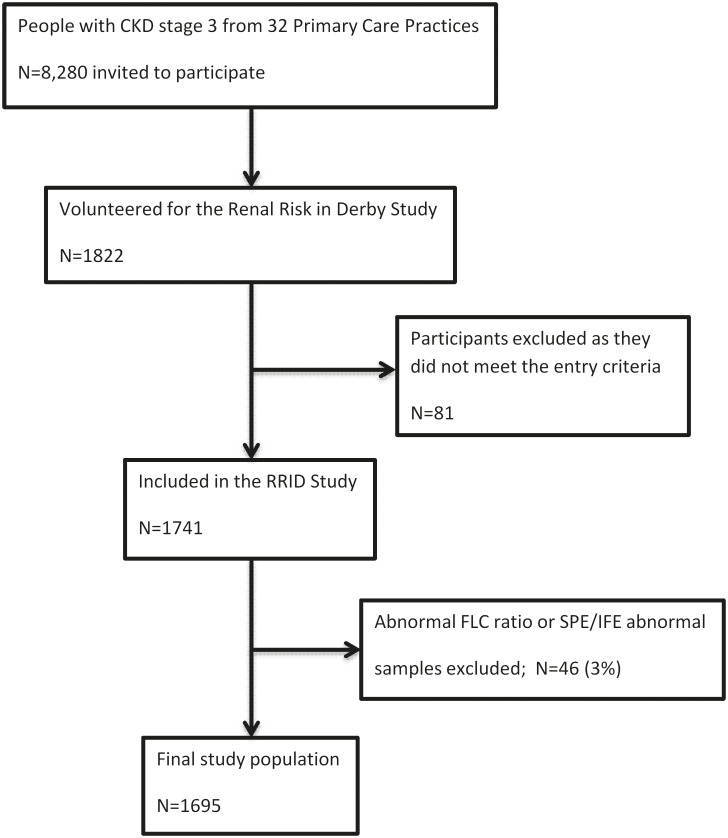
Study flow diagram.